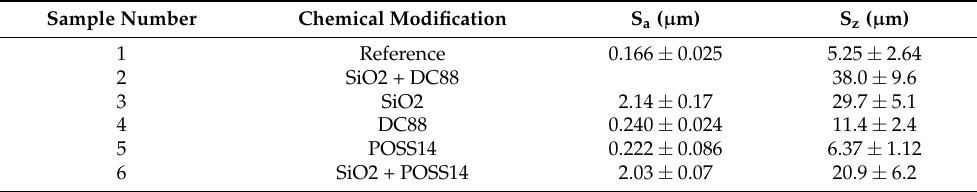
Table 2. Roughness parameters of the samples.